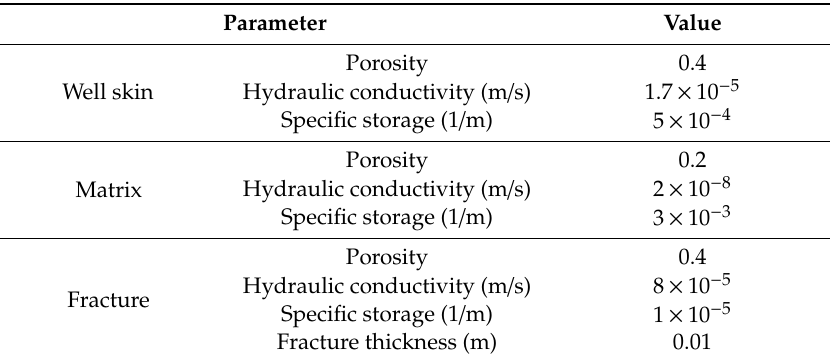
Figure 9. Diagnostic plot of ( a ) the field drawdown data and ( b ) the model data. The black squares and the blue crosses represent the drawdown and the logarithmic derivative of the drawdown as a function of time (ds / dt × t), respectively. Table 1. Parameters of the numerical